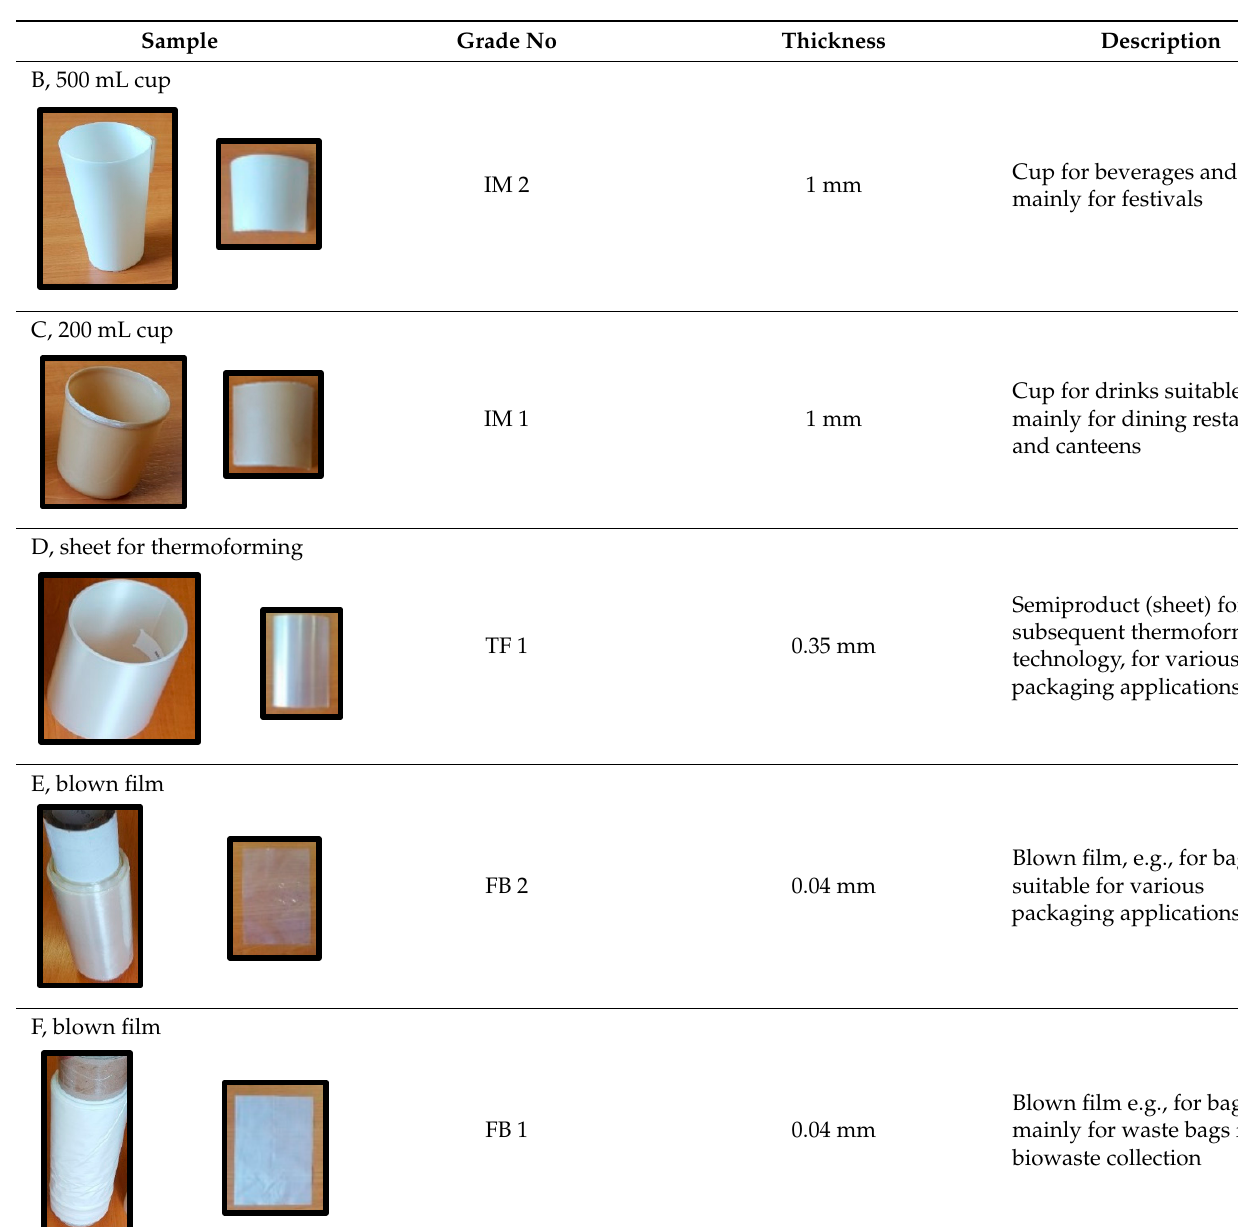
Table 2. Products that were tested for biodegradation and compostability.